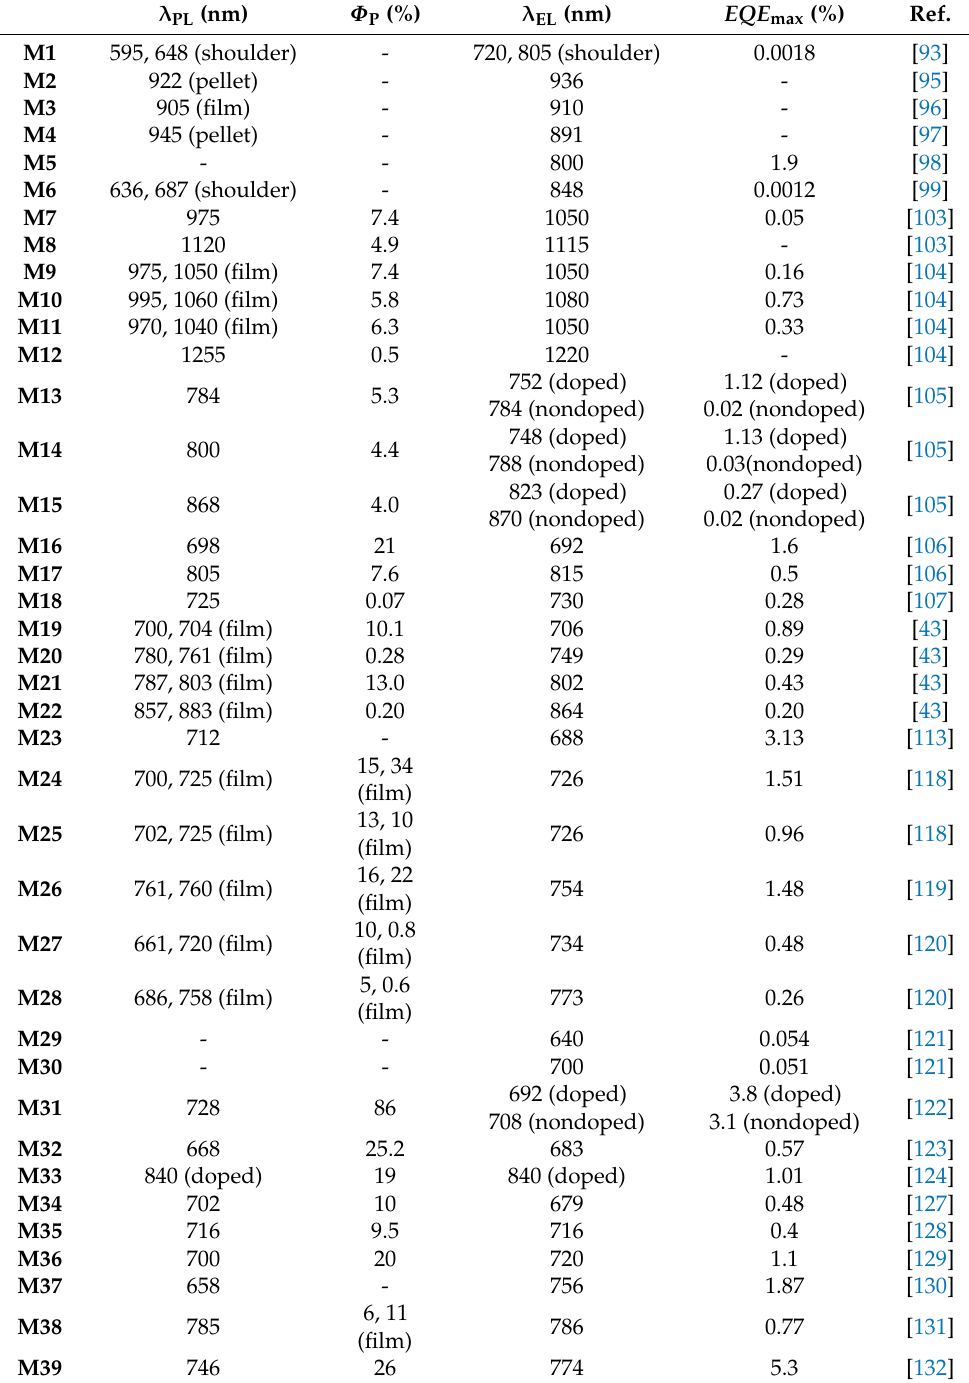
Table 2. Photophysical and electroluminescent properties of some NIR fluorescent organic